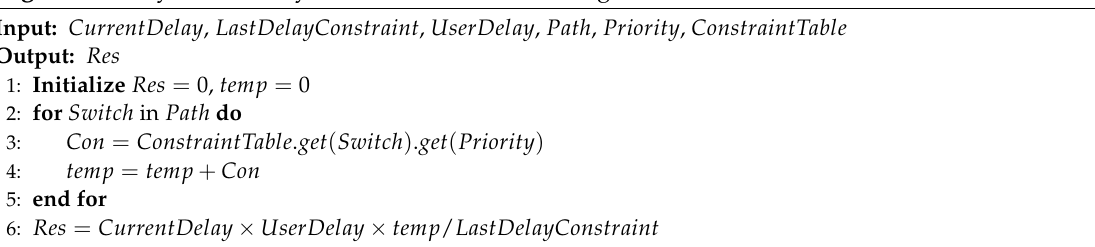
Algorithm 3 Dynamic Delay Constraint Calculation